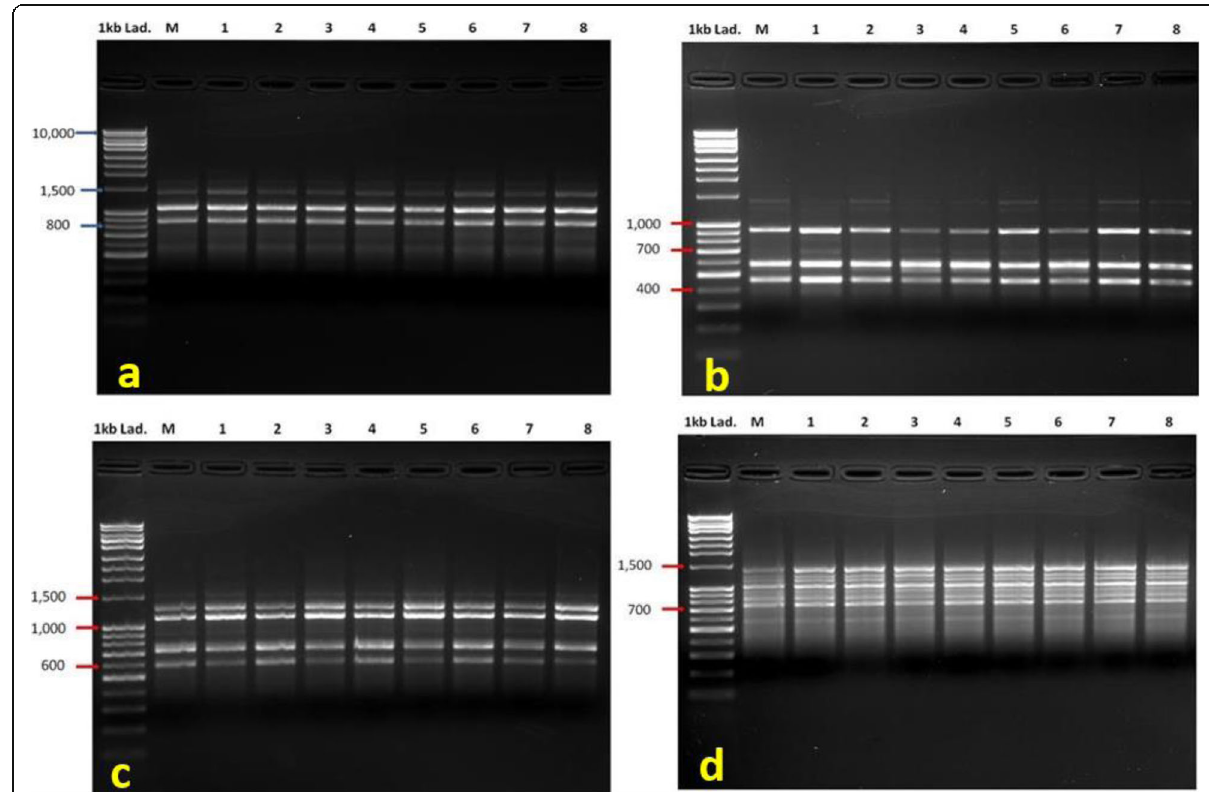
Fig. 5 DNA amplification profile of mother and in vitro propagated plants of A. pubescens generated by RAPD and ISSR primers. RAPD primer OPA-03 ( a ), RAPD primer OPI-07 ( b ), ISSR primer UBC-860A ( c ), and ISSR primer R(CA)7 ( d ). 1st lane is 1 kb DNA ladder, lane M-mother plant, lane 1 – 8 in vitro propagated plants